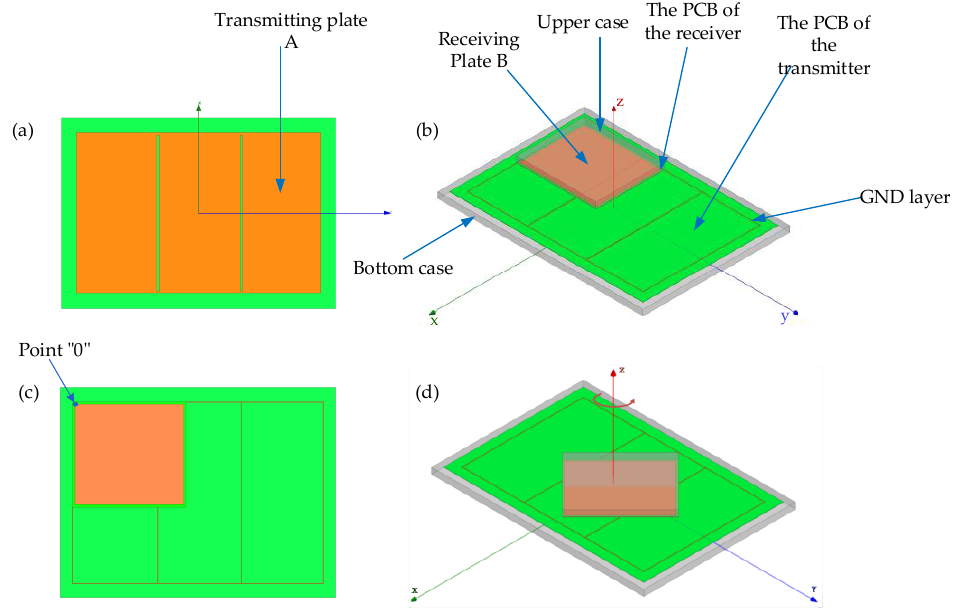
Figure 2. The structural views of the proposed CPT system, ( a ) the bottom view of the transmitting board; ( b ) the isometric view of the CPT system; ( c ) the top view of the CPT system; ( d ) with rotating receiving plate.